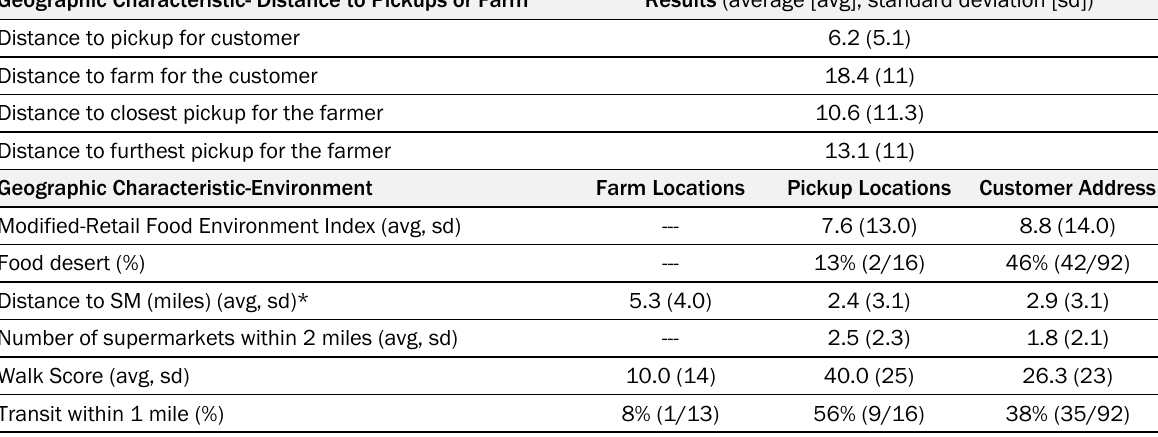
Table 1. Geospatial Characteristics of Environmental Context of Farms ( n =12), Pickup Locations ( n =16), and Customer Residential Locations ( n =92) Geographic Characteristic- Distance to Pickups or